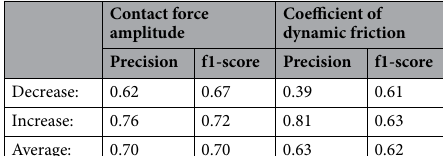
Coefficient of dynamic friction